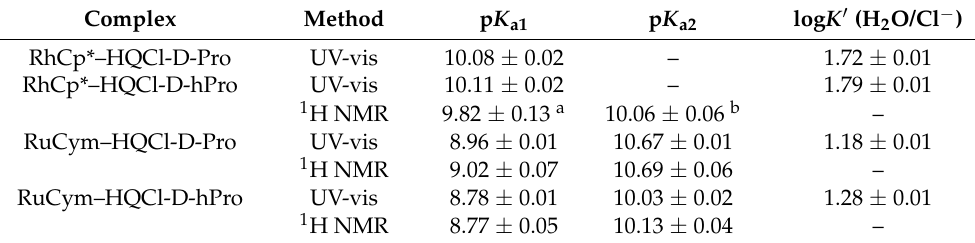
Table 3. Proton dissociation constants (p K a ) and conditional H 2 O/Cl − exchange constants (log K (cid:48) (H 2 O/Cl − ) of the complexes (see equilibria in Scheme S1). { I = 0.2 M KNO 3 ; T = 25.0 ◦ C}.